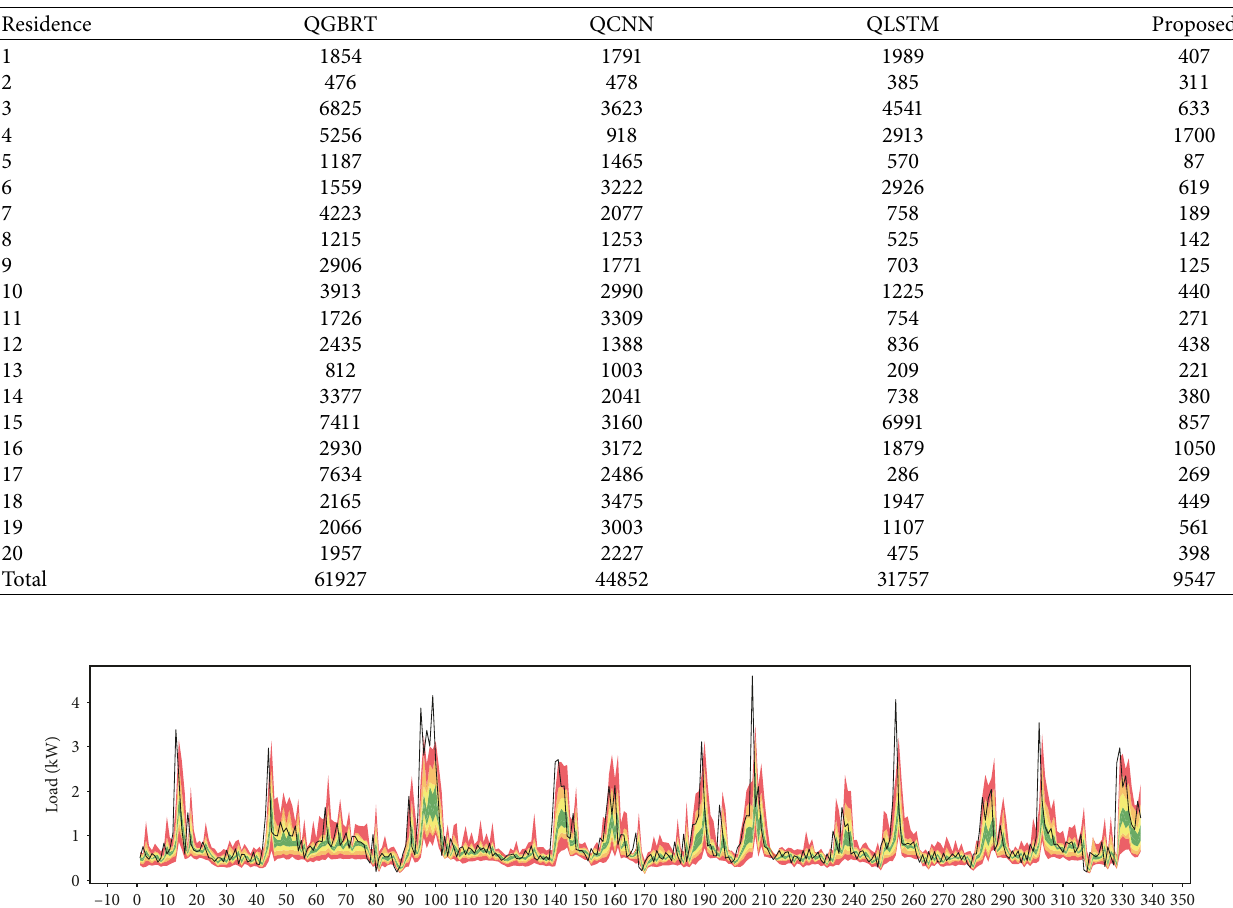
Table 3: Inversion error statistics.